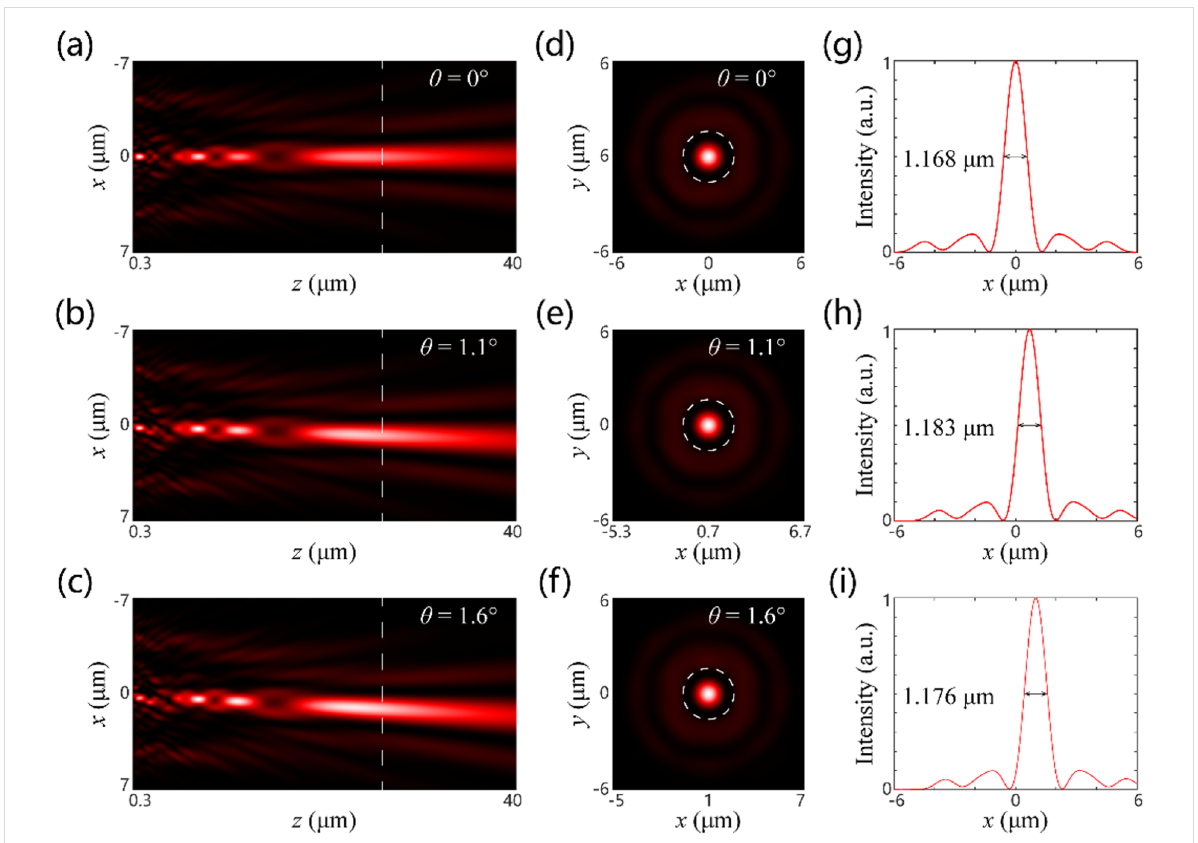
Figure 5: Simulated intensity distributions for different incident angles with LCP incidence corresponding to the SSL with long focal length. (a–c) Inten- sity distributions along the propagating direction. The dashed white lines represent the focal plane of the SSL. (d–f) Intensity distributions in the focal plane. The dashed white circles represent the diffraction-limited focal spot (Airy disk). (g–i) Intensity distributions of the sub-diffraction spot along the x